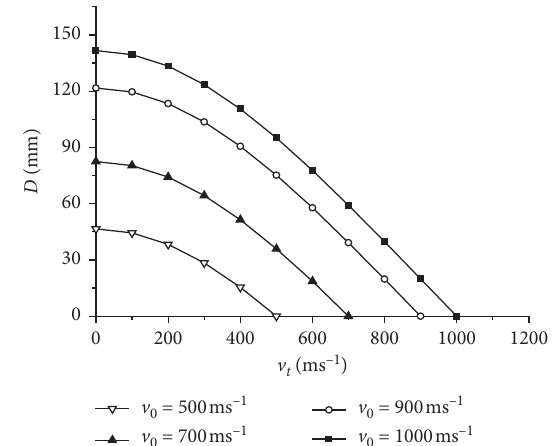
Figure 6: Relationship between penetration depth and penetration velocity.